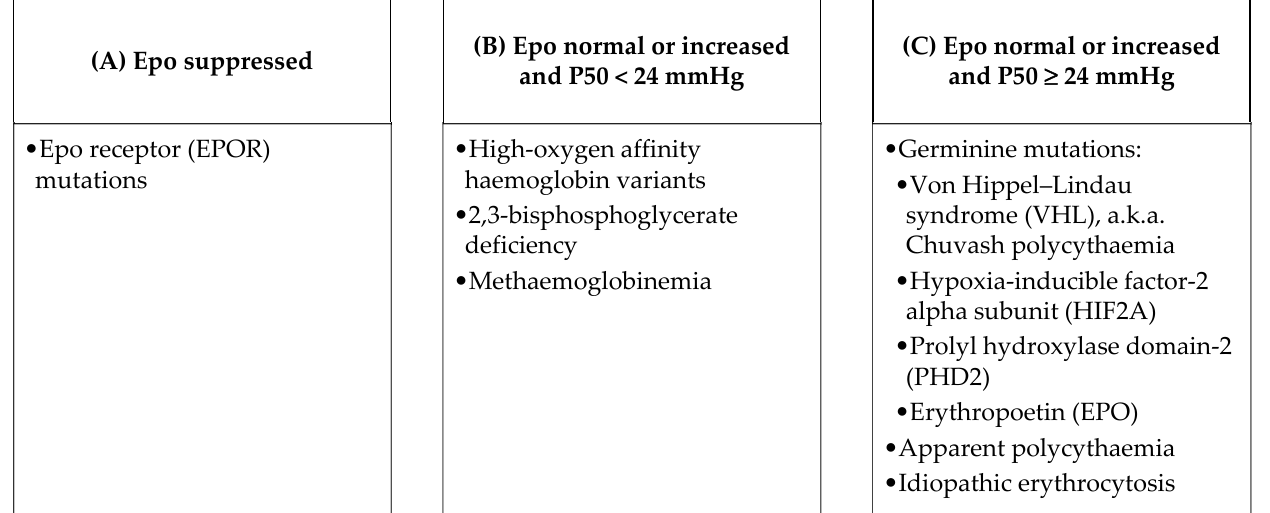
Figure 1. Potential causes of hereditary polycythaemia according to Epo and P50 levels, as reported in the literature.